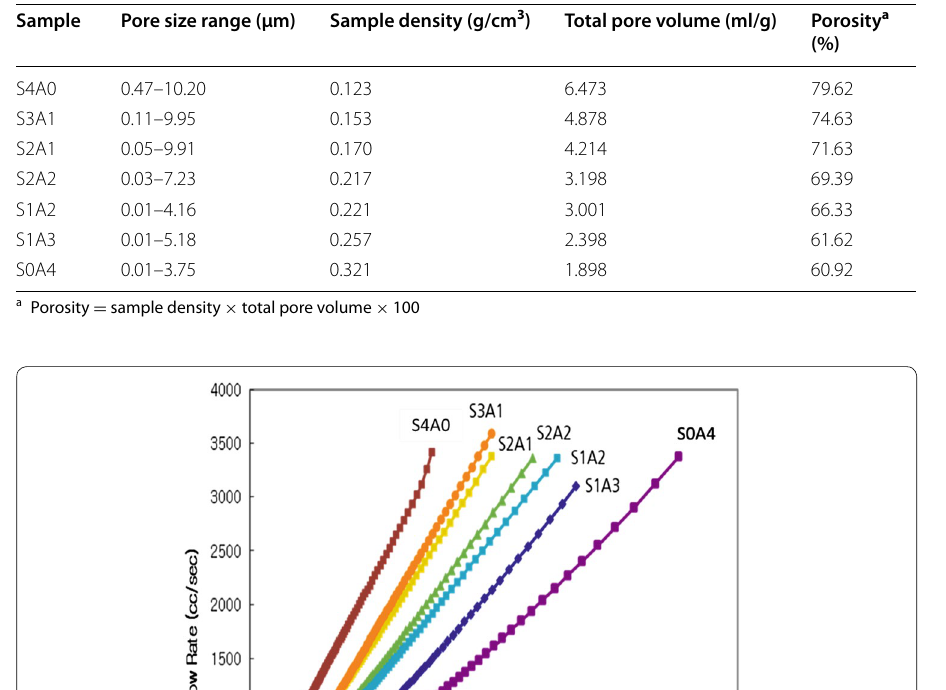
Table 2 Pore size range, total pore volume and porosity of PS/PA6 blend webs